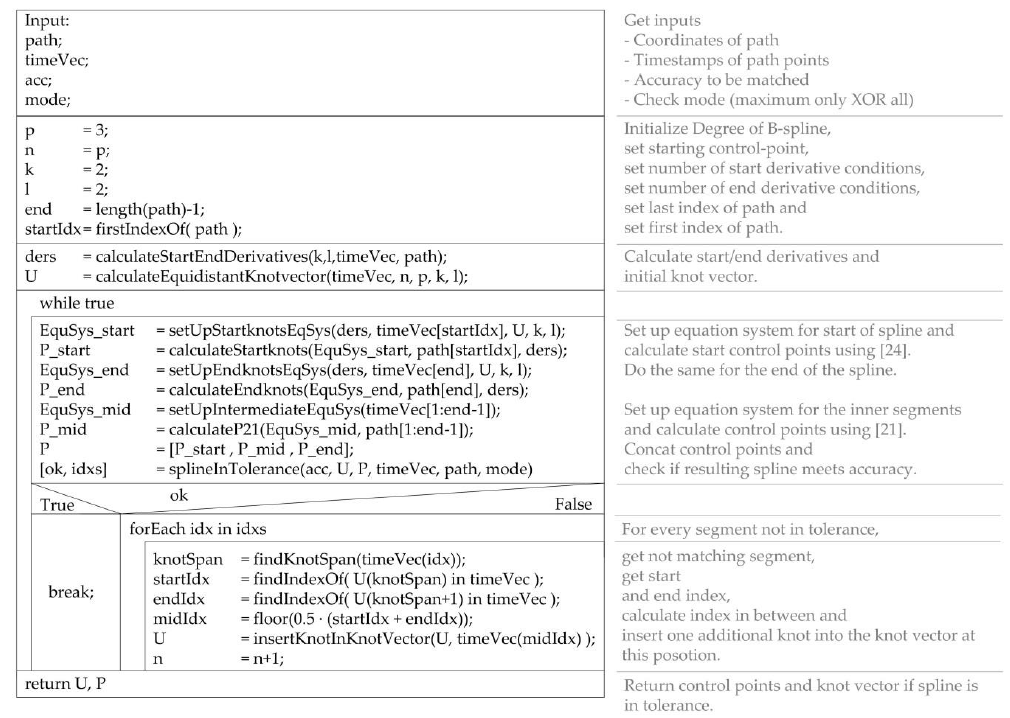
Figure 3. B-spline-based least square algorithm bsLSQ, using [24] .